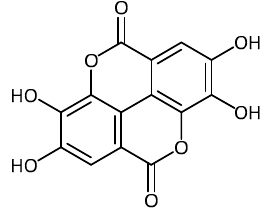
Figure 9. Structure of ellagic acid.